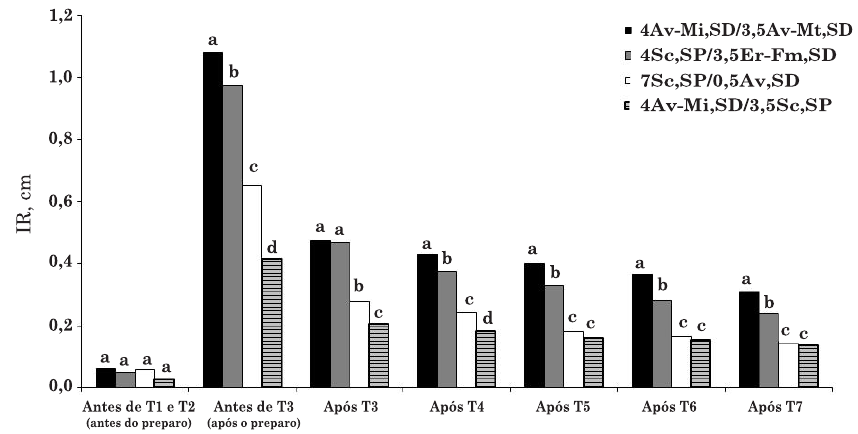
Figura 2. Índice IR da rugosidade superficial do solo criada pelo preparo em momentos distintos durante a realização dos testes de erosão com chuva simulada (condição superficial nos testes: T1=solo não mobilizado e completamente coberto; T2=solo não mobilizado e descoberto; T3 a T7=solo sucessivamente mobilizado com grade leve e descoberto) nas sequências culturais estudadas (valores médios de duas repetições por tratamento). Colunas sobrepostas com a mesma letra, no mesmo teste de chuva, não diferem estatisticamente entre si (Duncan, p < 0,05).